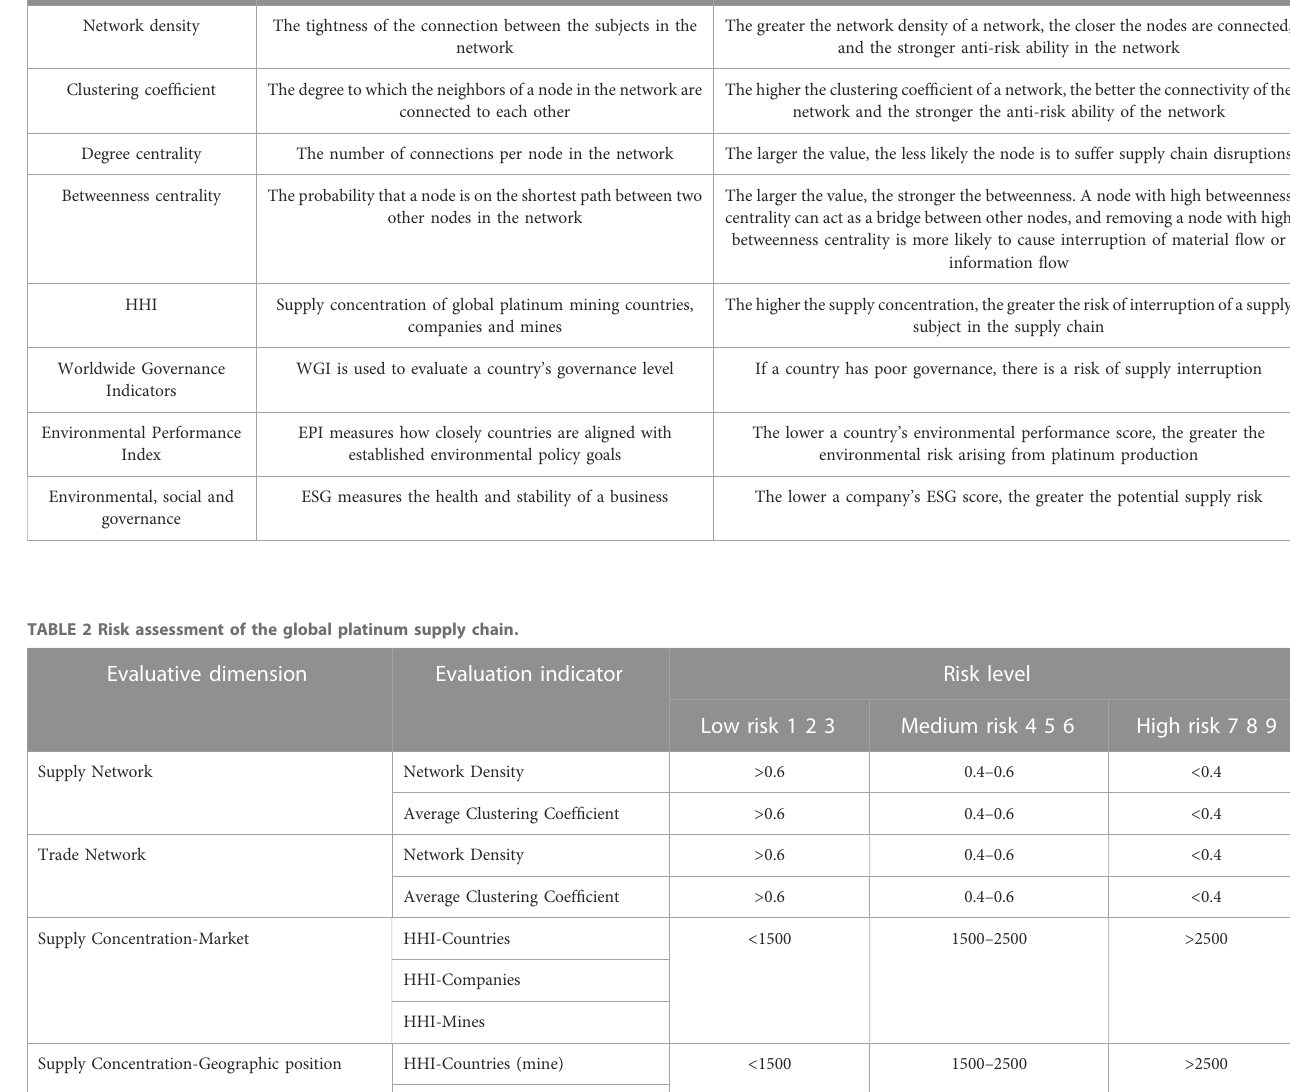
TABLE 1 Indicator description and supply chain risk explanation. Indicators Description Network density